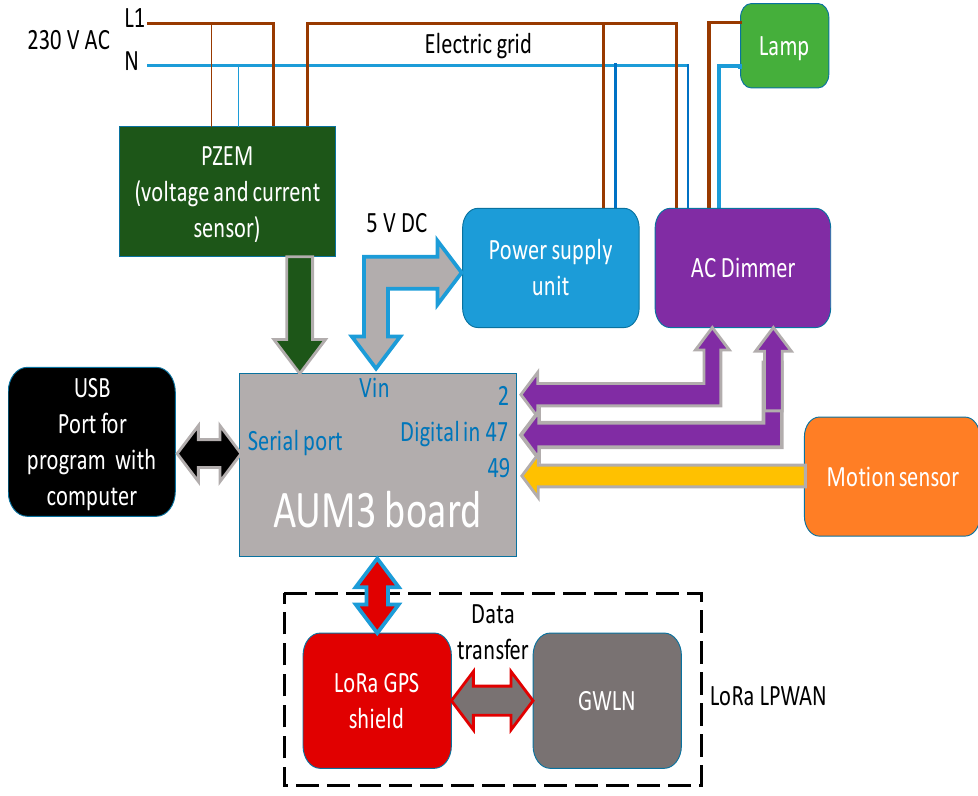
Figure 4. Hardware block diagram of MCDSL.